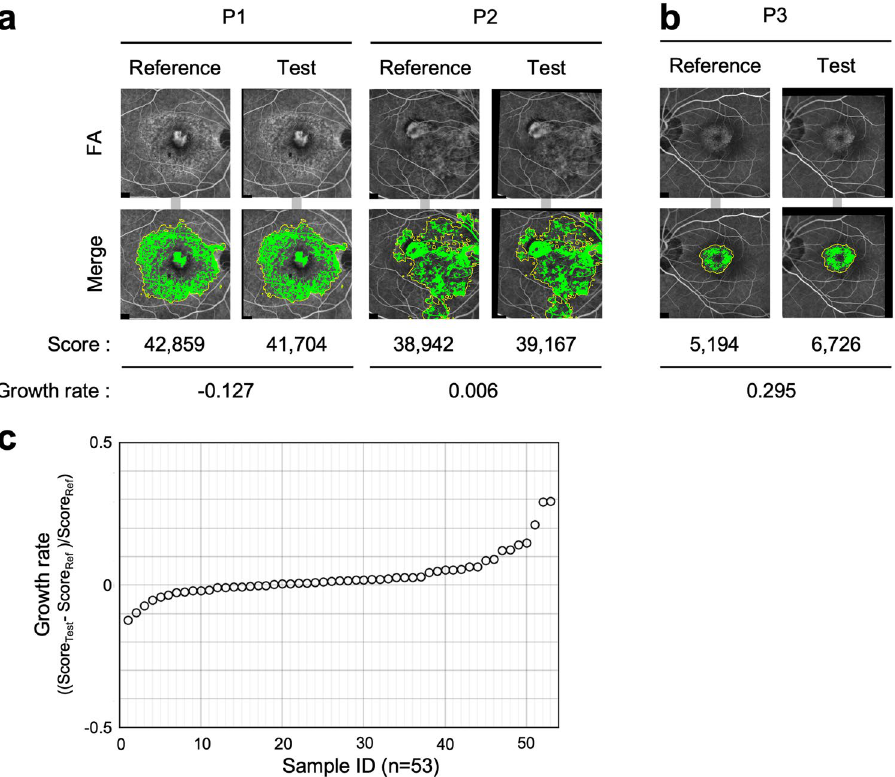
Figure 4. Error validation using the sample FA images from the same eyes. ( a ) A typical pair of images from two patients on the same day. Upper: A pair of FA images that are aligned and brightness corrected by image processing. Lower: Output binary images. Yellow frames represent Abnormal regions predicted by the U-Net. Green areas represent Hyperfluorescent areas. The Score represents the sum of the pixel numbers of the Hyperfluorescent area in the binarized image. The Growth rate is represented as (Test score—Reference score)/ Reference score. ( b ) A pair of images with the highest Growth rate. Upper and Lower: represent the same as ( a ). ( c ) Graph showing the Growth rate